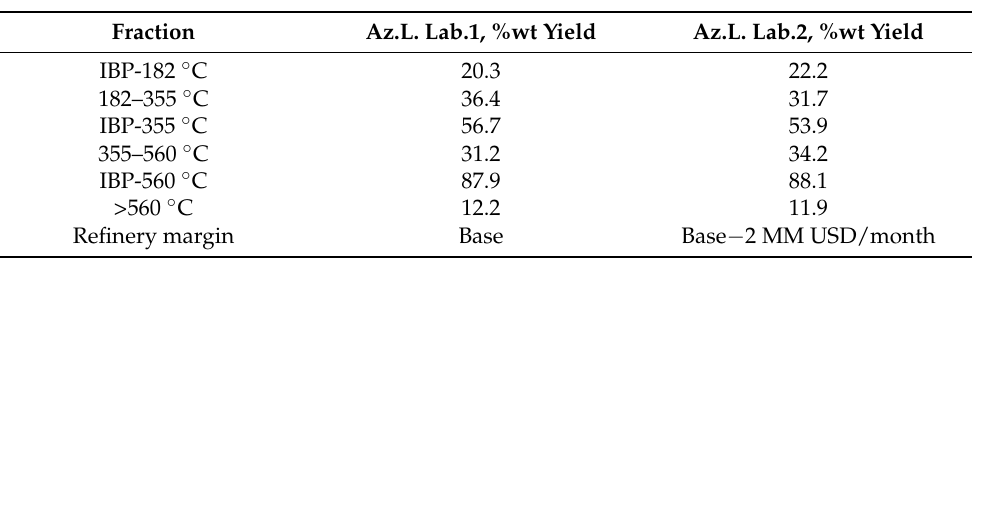
Table 5. TBP fraction yields of Azeri Light crude oil measured in two different laboratories and estimated refinery margins using the refinery LP model (Honeywell Refinery and Petrochemistry modeling System (RPMS)) and employing the TBP distillation yields measured in both